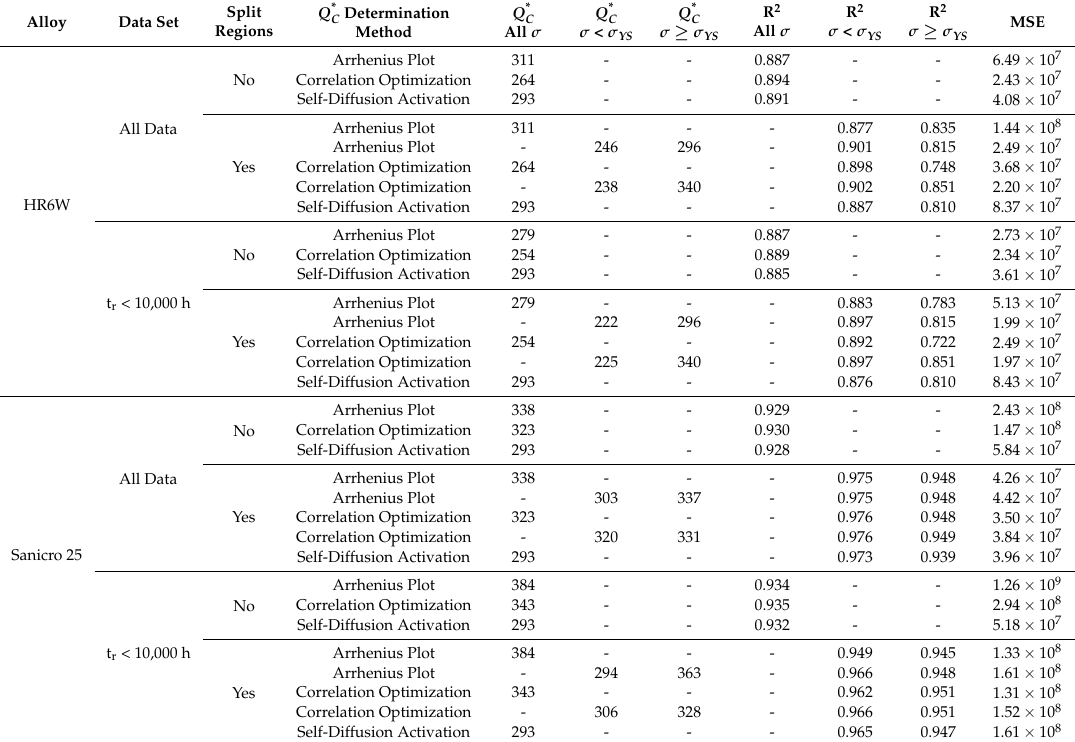
Table 4. Quality of fit and